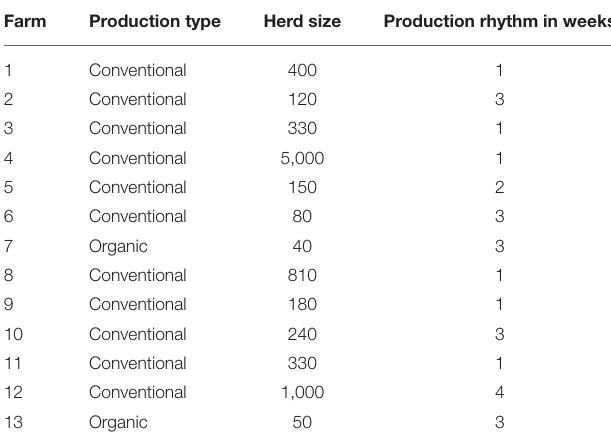
TABLE 1 | Characteristics of the 13 farms in the present